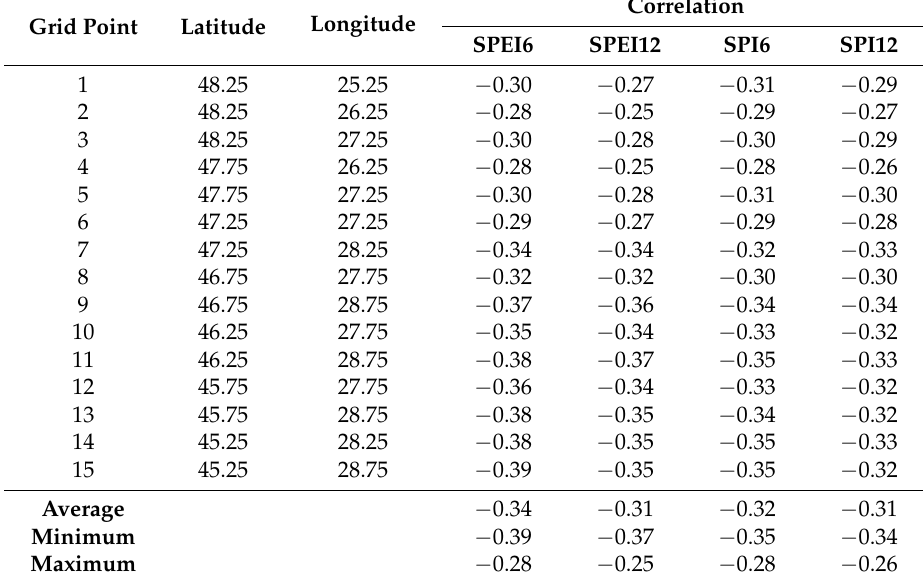
Grid Point Latitude Longitude